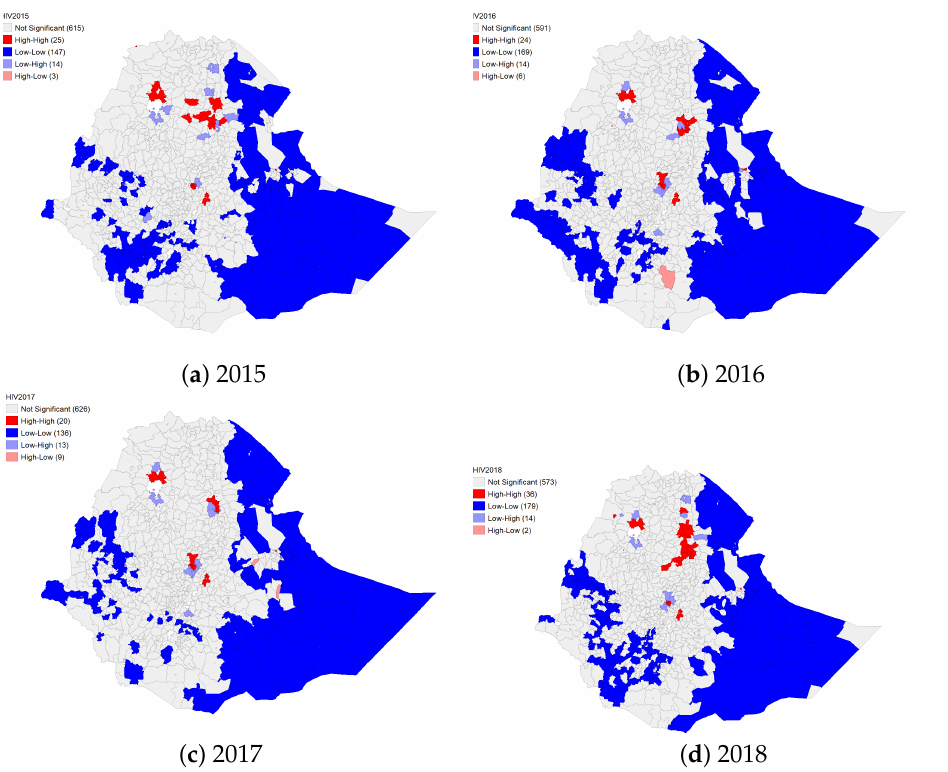
Figure 2. Spatial clusters and spatial outliers of HIV cases in Ethiopia at district level from 2015 to 2018 using the local Moran’s I